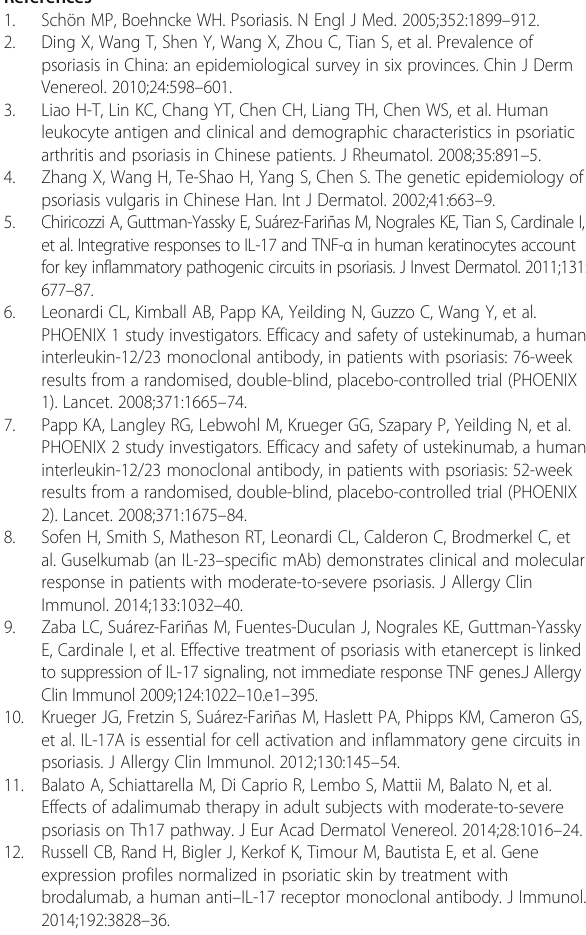
Additional file 3: Enrichment of ingenuity pathways by gene signature of Indigo naturalis treatment of moderate psoriasis from our